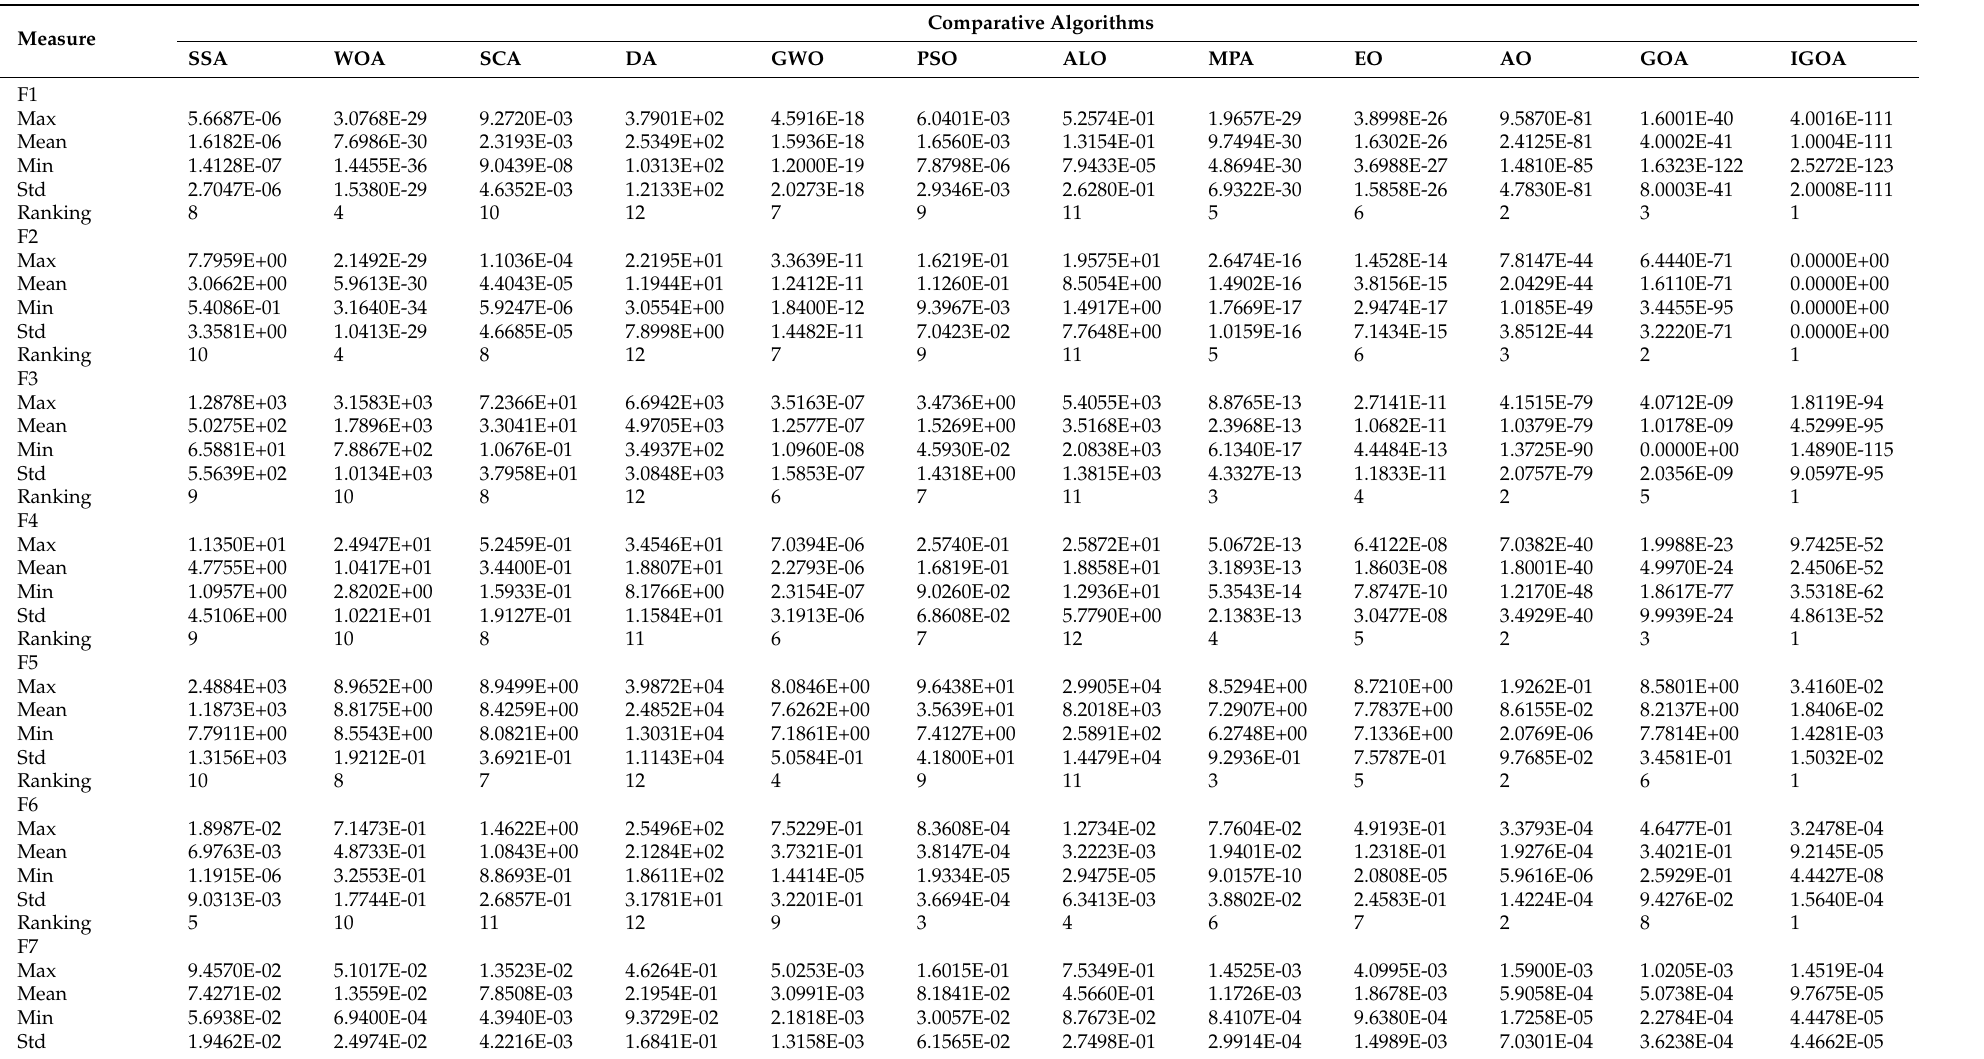
Table 4. The results of the proposed IGOA and other comparative methods using classical benchmark functions (F1–F13), where the dimension size is